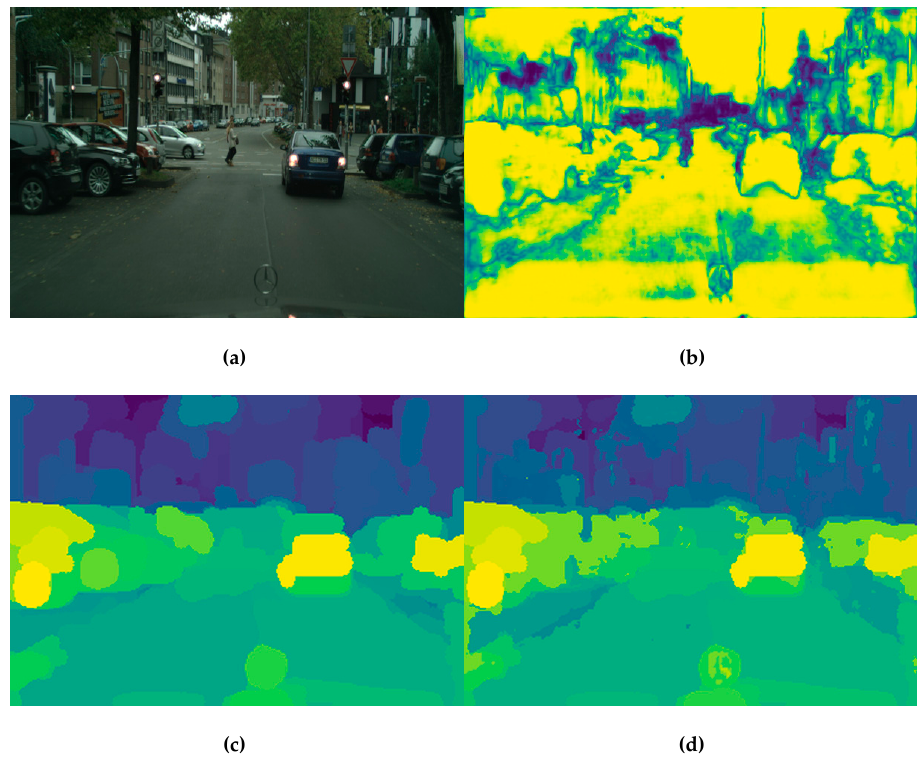
Figure 10. ( a ) Input image, ( b ) fusion score map (FSM), ( c ) segmented score mapping (SSM) for class ‘car’, ( d ) guided segmentation mapping (GSSM) for class ‘car’.